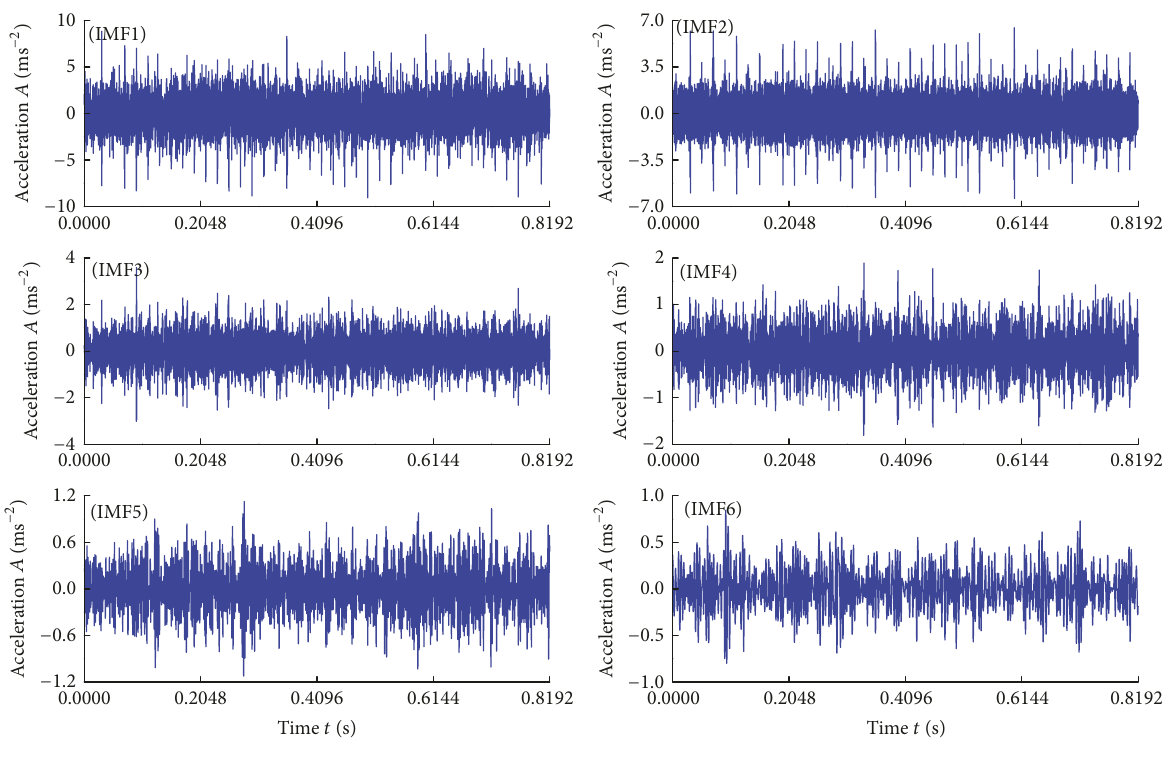
Figure 4: IMFs obtained by EEMD.